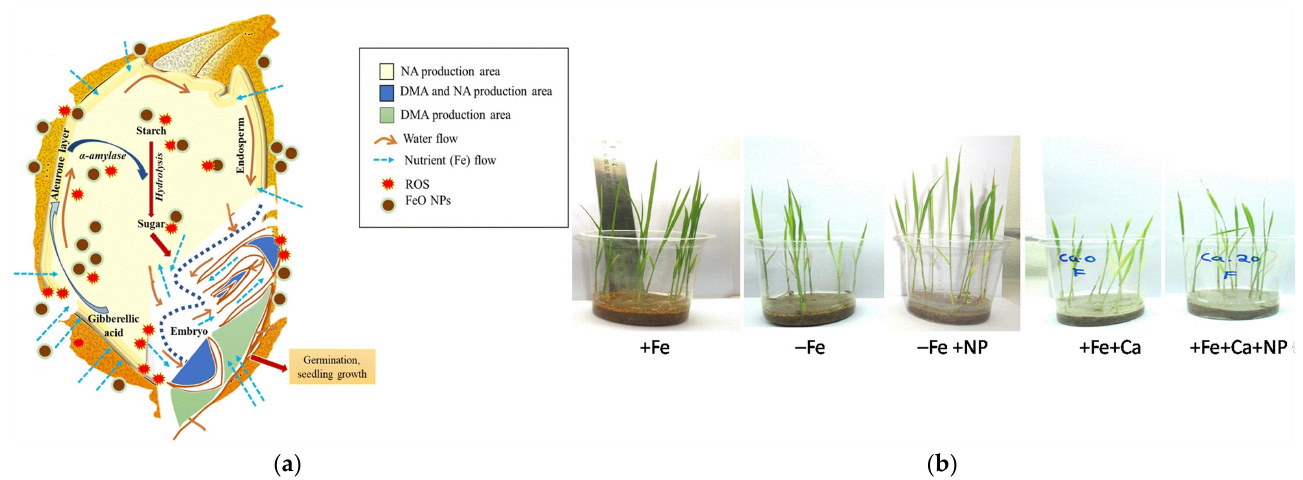
Figure 1. ( a ) A model of iron-oxide-nanoparticle-induced germination in rice. Reprinted with permission from Ref. [24]. 2021, Springer-Verlag; ( b ) rice growth response. Reprinted with permission from Ref. [26]. 2017, American Chemical Society.